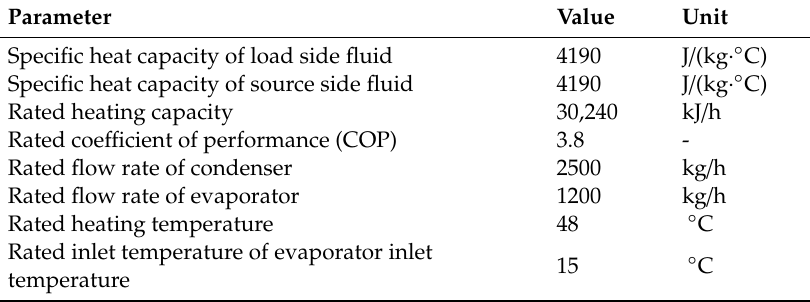
Table 4. Description of the low-temperature water source heat pump (LHP).